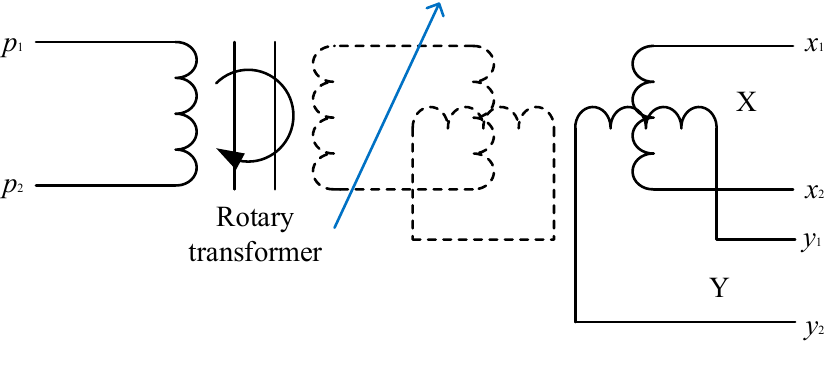
Figure 4. RVDT structure.